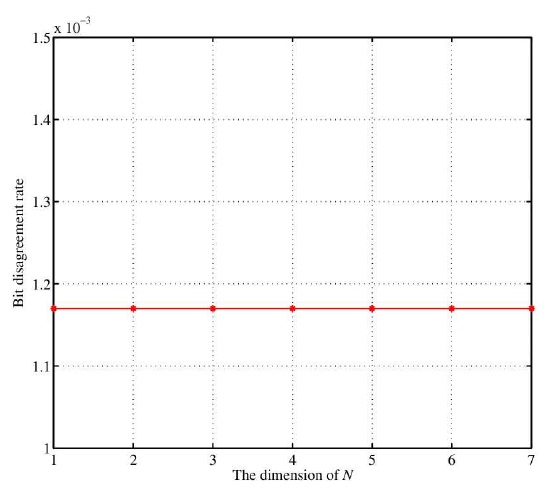
Figure 9. The variation of the bit disagreement rate with the dimension.